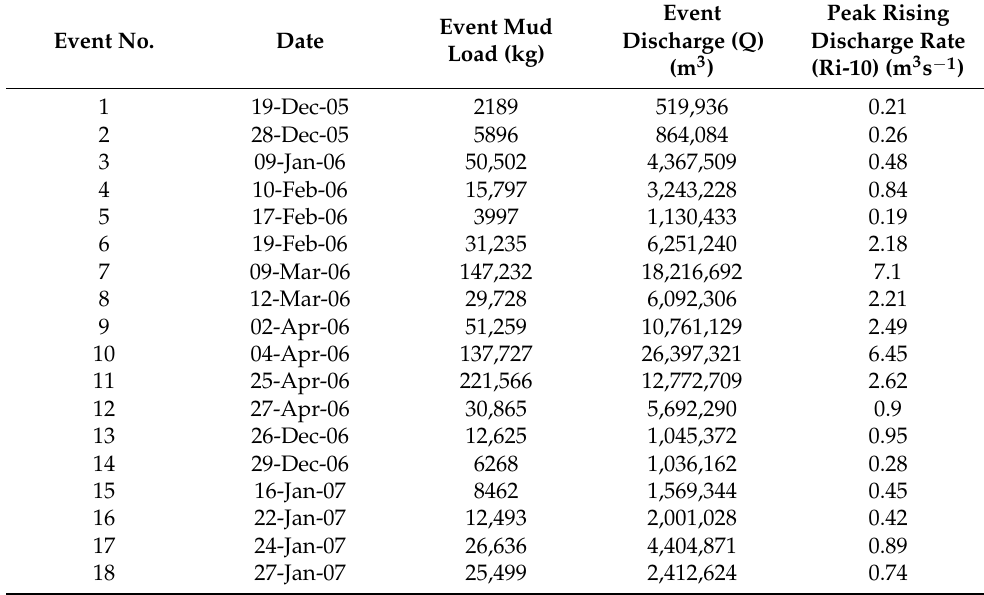
Table A3. MCDS Event data